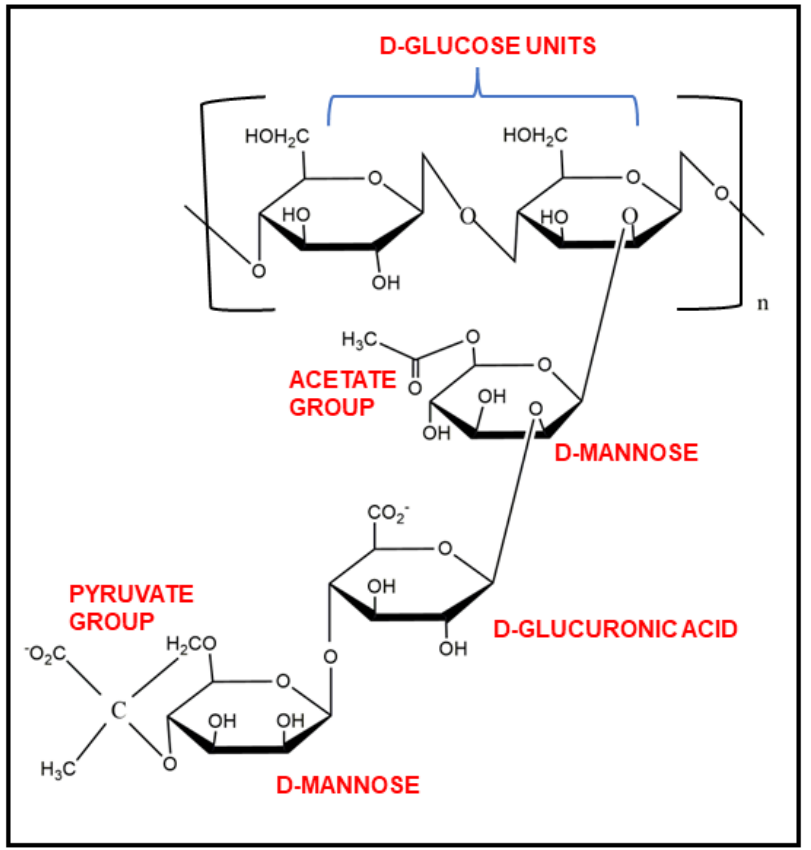
Figure 1. Chemical structure of xanthan gum and its functional groups.